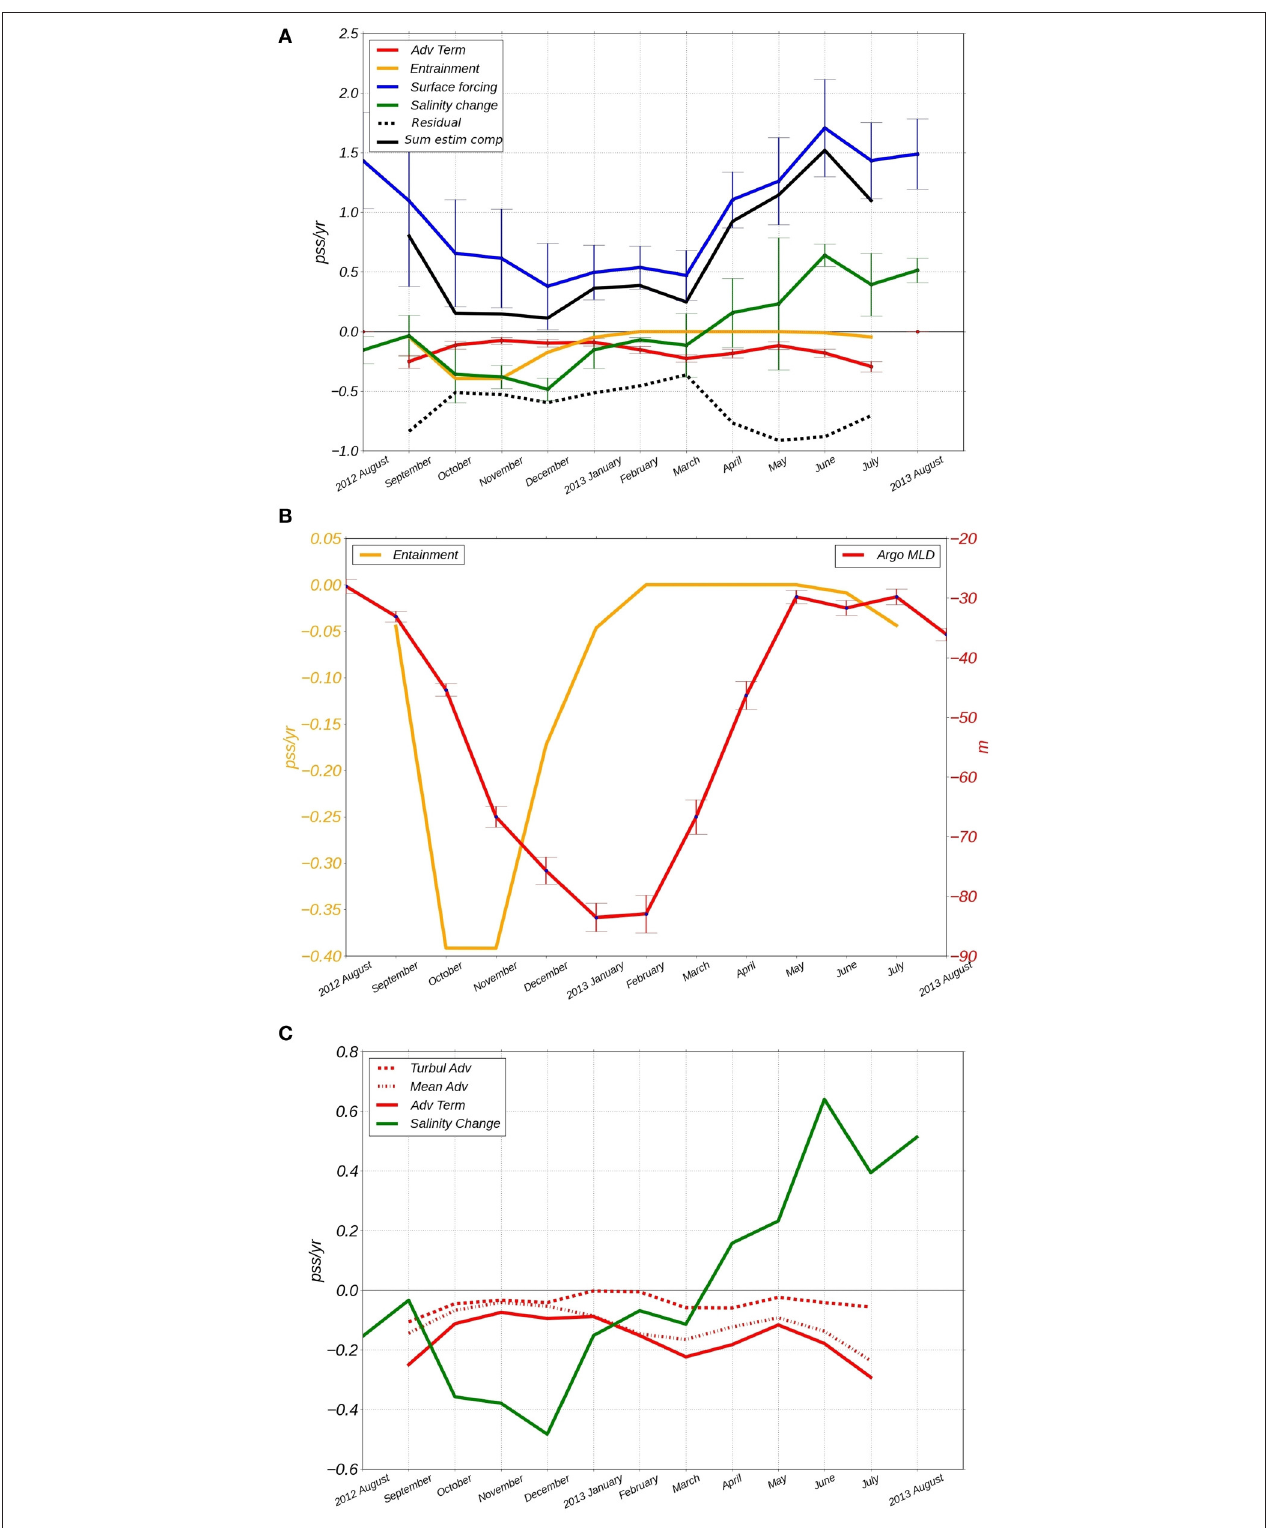
FIGURE 9 | (A) —components of salinity budget, residual (black dashed curve) and the sum of all estimated components of the right side of the Equation (1) (black curved); (B) —entrainment (orange curve) and Argo MLD (red); (C) —salinity change (green) and advection components (red).